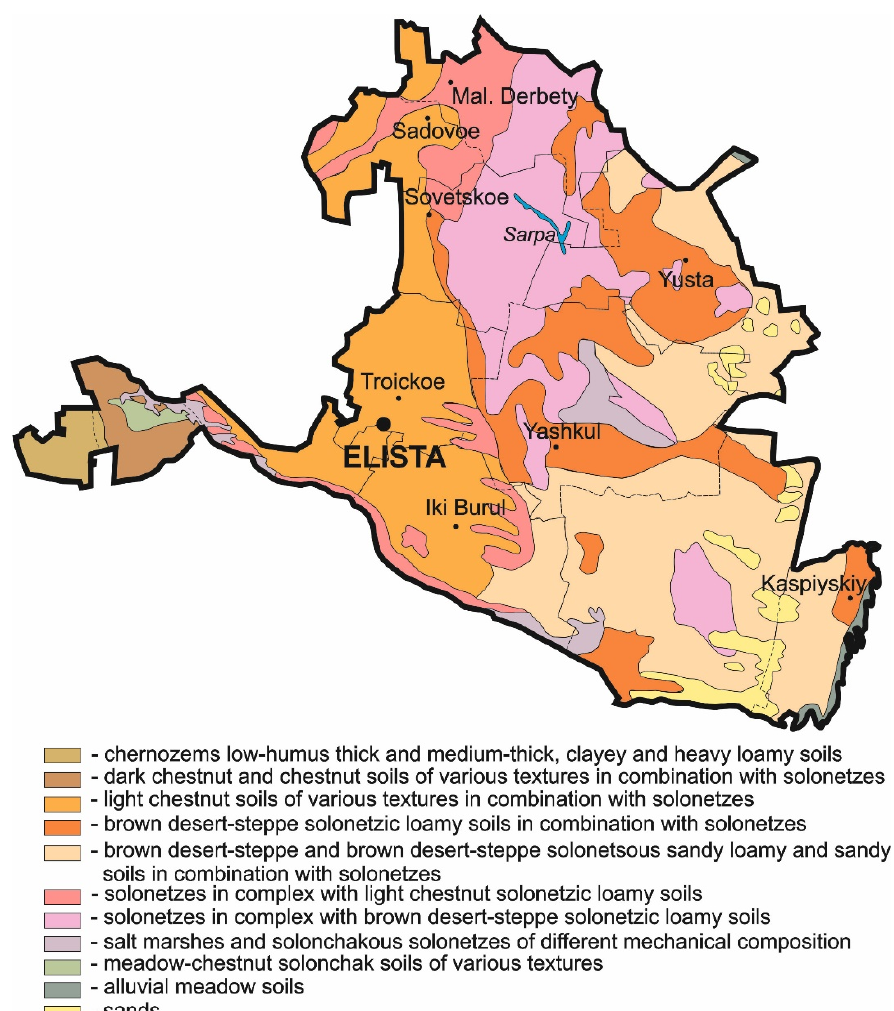
Figure 2. Soils of the Republic of Kalmykia in south Russia.